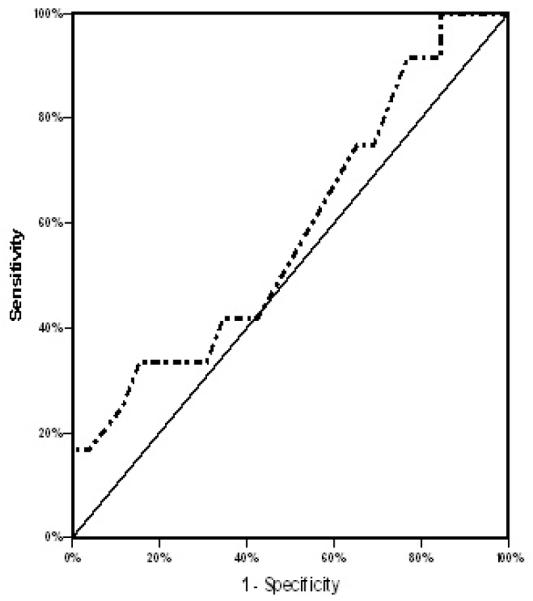
ROC curve using MaxSUV to predict DFS. Area under the curve is 0.564, and the best cut-off value is 8.0.